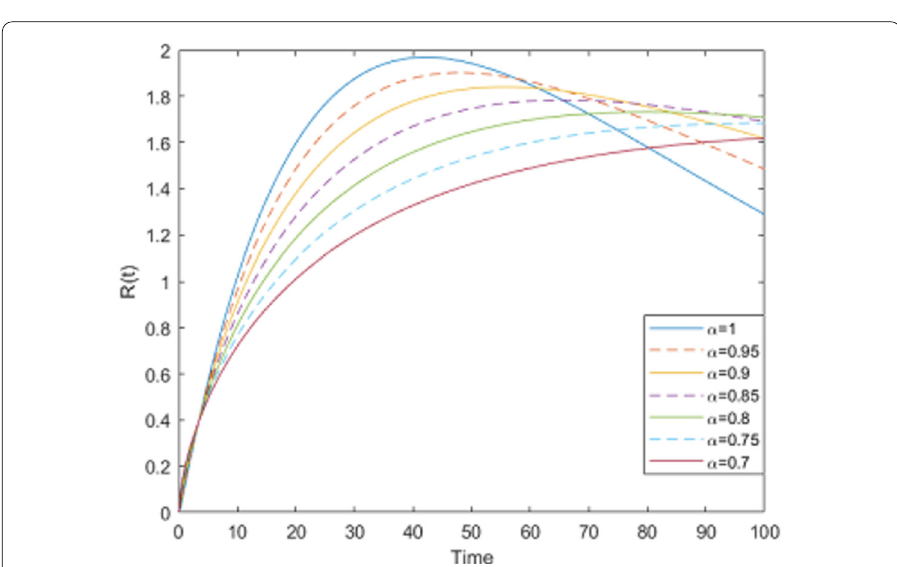
Figure 12 The class of researchers that overcome